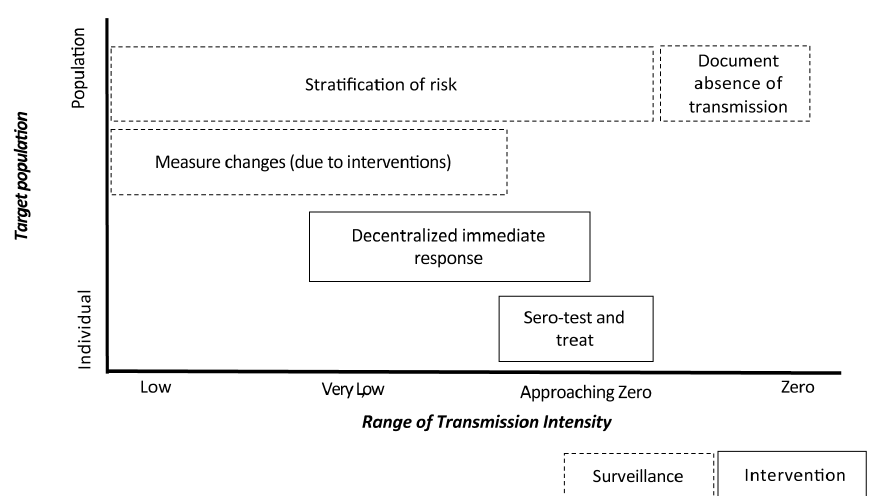
Figure 1. Priority applications of serological markers of